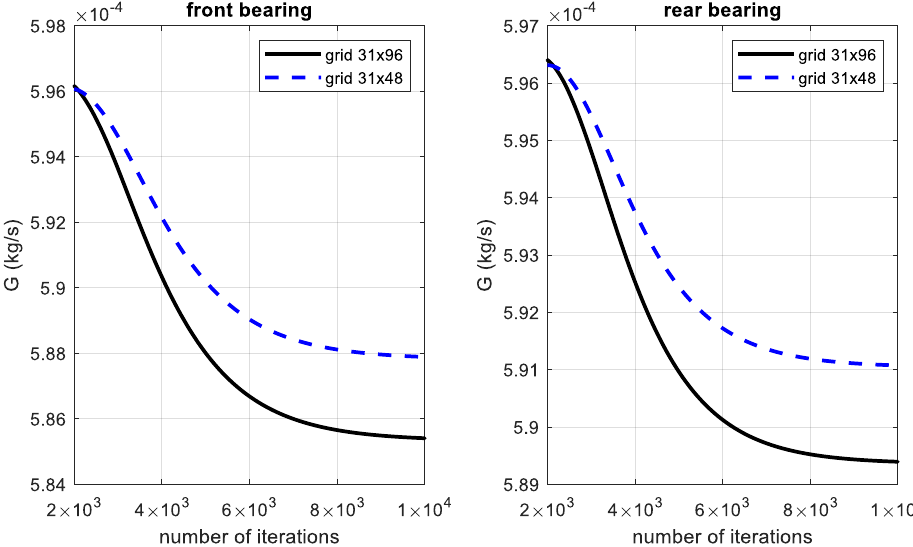
Figure 9. Load capacity vs. number of iterations obtained with different grid numbers along the circumferential direction.